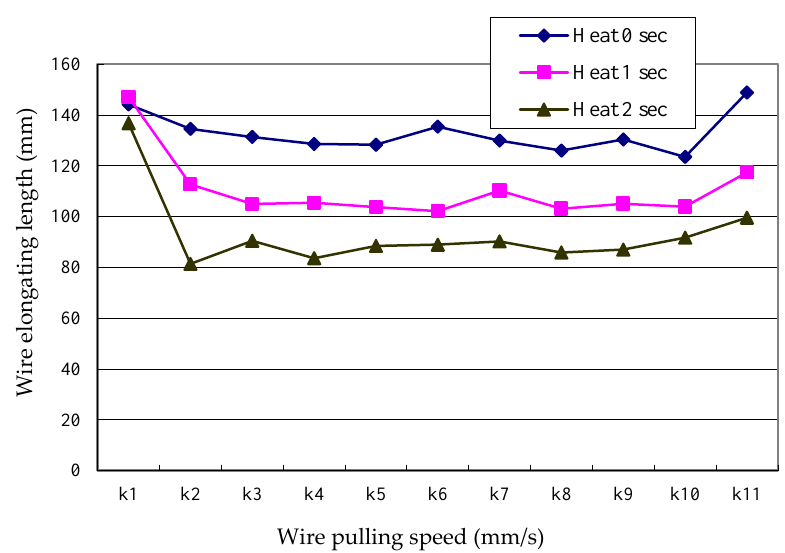
Figure 11. Wire elongating length vs. wire pulling speed for 0.6 mm wire at different heating period.